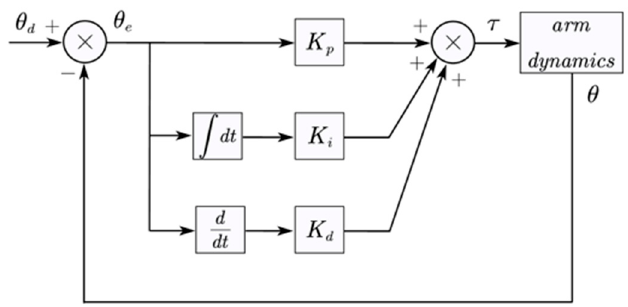
Figure 7. Schematic diagram of PID type controller.